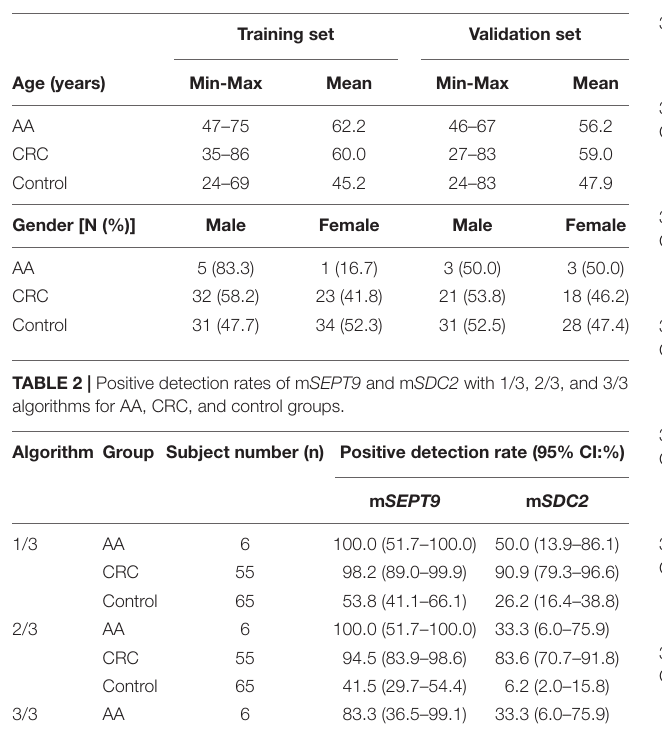
TABLE 1 | Subjects characteristics.